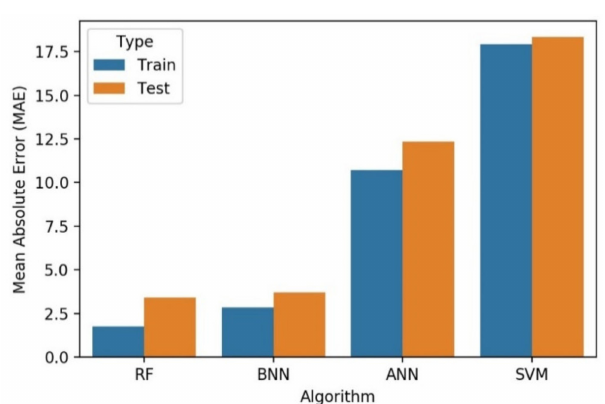
Figure 8. Analysis of root mean square error.